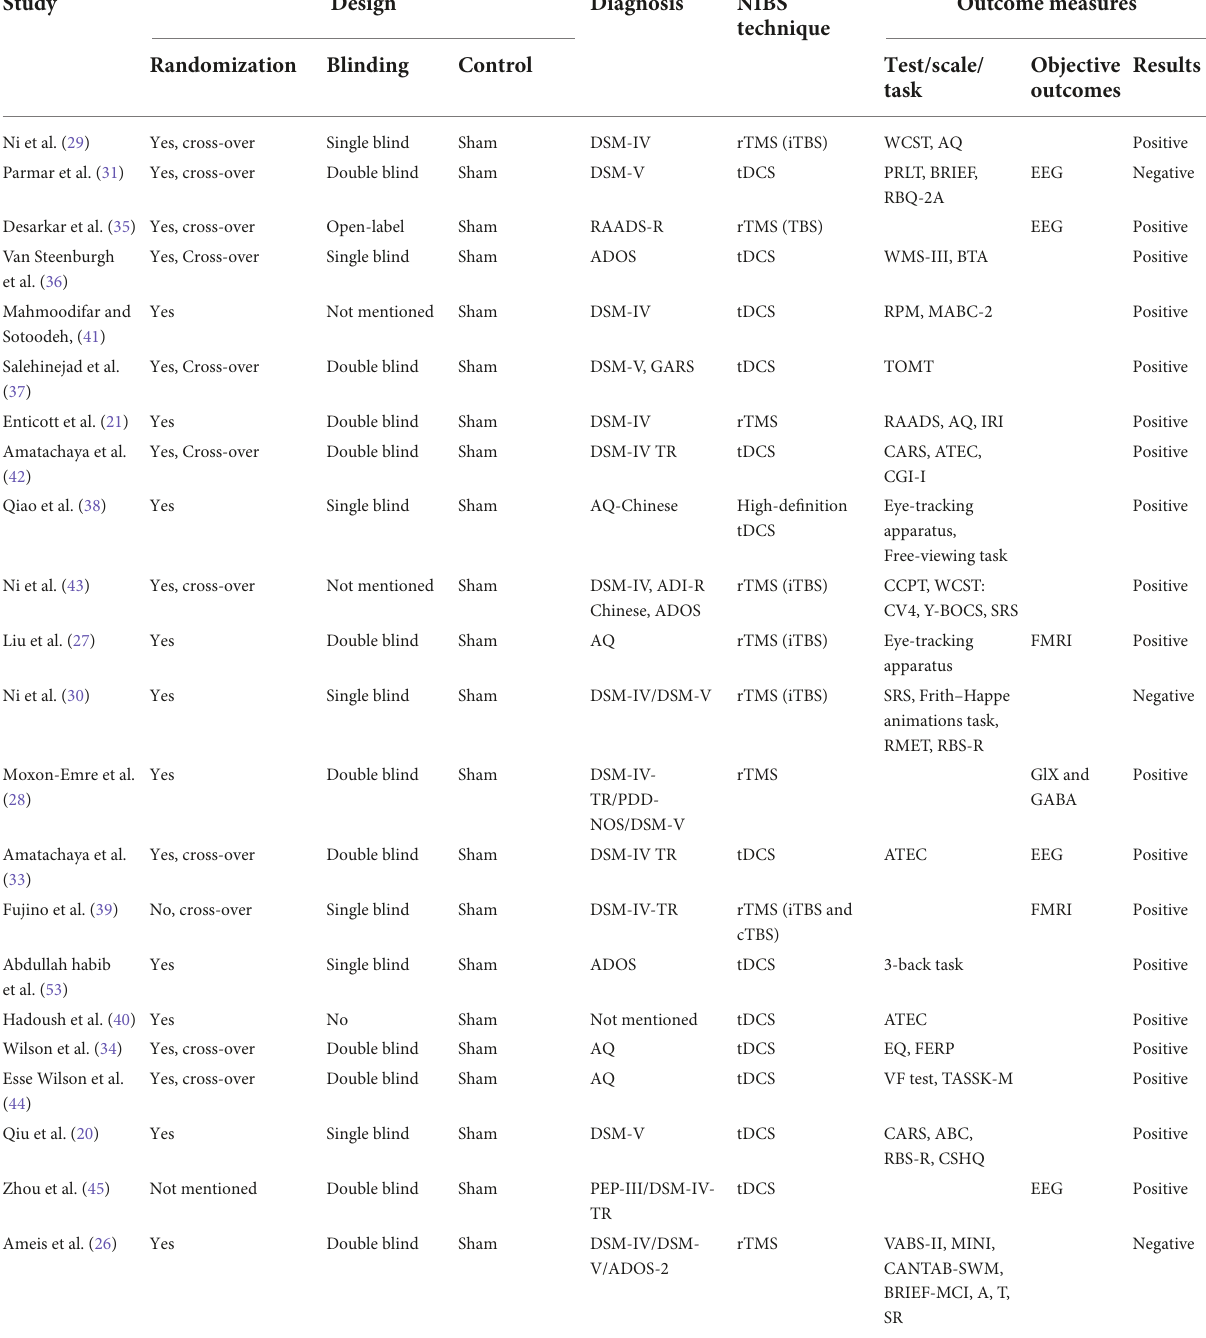
TABLE 1 Characteristics of studies on sham-controlled clinical trials on transcranial direct current stimulation/transcranial magnetic stimulation interventions in autism spectrum disorder.